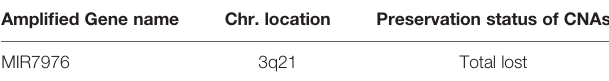
TABLE 4 | Lost of gene CNA gain in patient-derived primary cells compared to their original tumors in the GBM group.